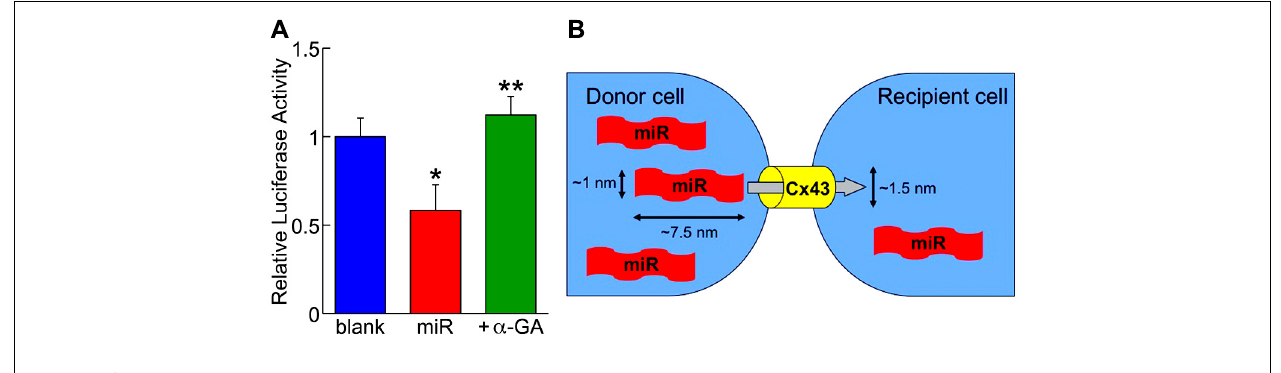
FIGURE 2 | (A) The repressive activity of translocated miR-499 (miR) on the 3 (cid:2) -untranslated region of SOX6 gene is abolished by the gap junction inhibitor ( + α -GA). Blank indicates donor cells transfected with empty plasmid.